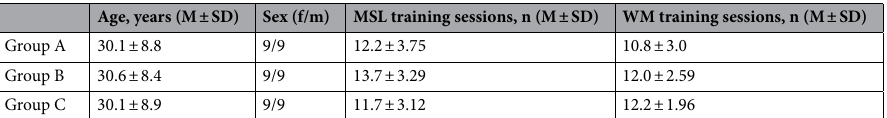
Table 1. Demographic characteristics and training adherence for the three groups. M, mean; SD, standard deviation; n,